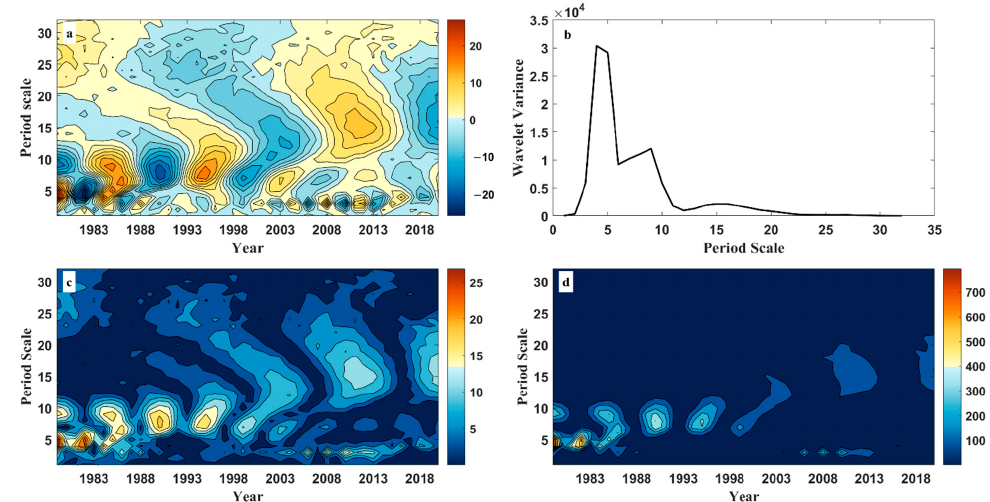
Figure 4. Wavelet analysis results of the cumulative days of Ural Mountains blocking high in extended winter (( a ): real part of wavelet coefficient; ( b ): wavelet variance; ( c ): modulus of wavelet coefficient; ( d ): modulus square of wavelet coefficient).